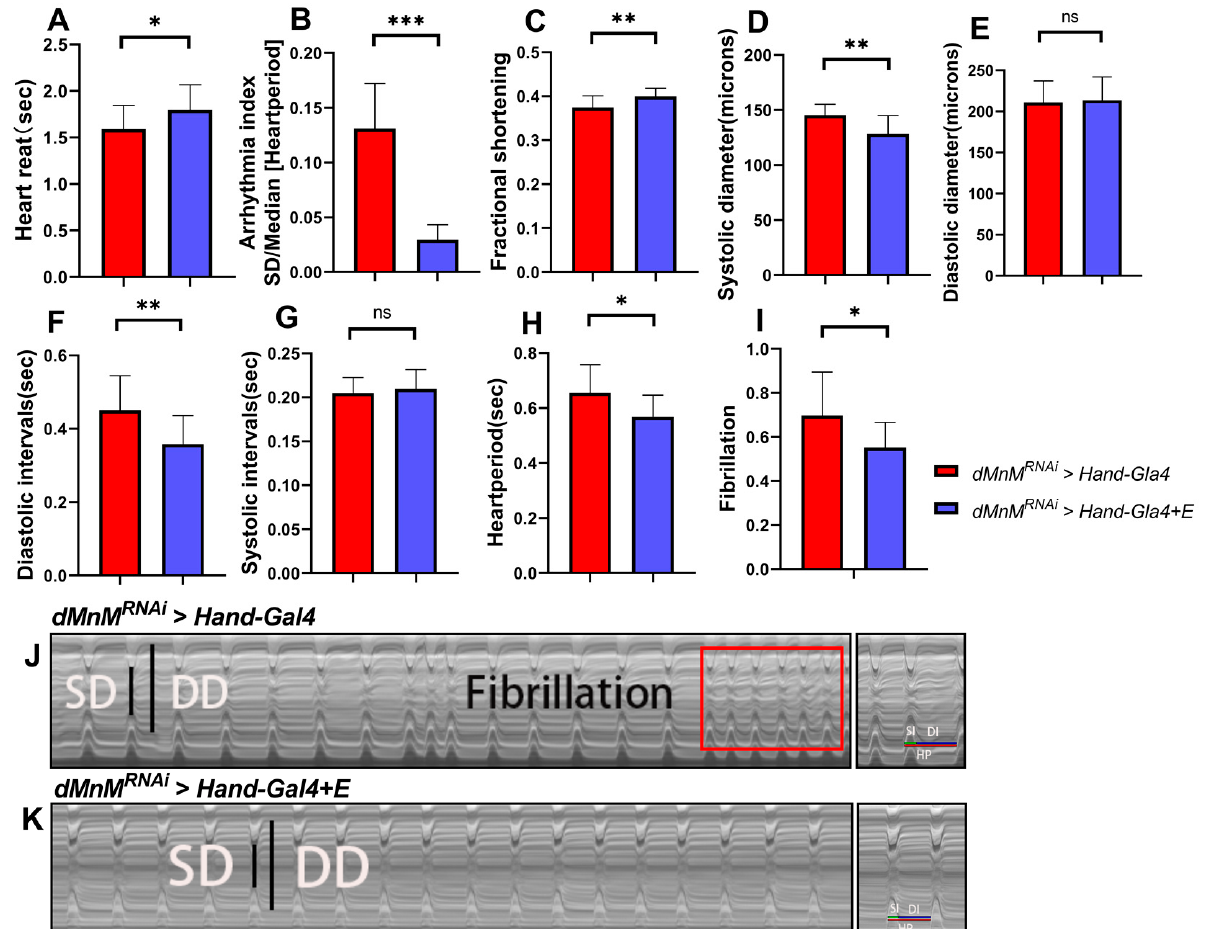
Figure 5. Effect of regular exercise on dMnM-specific knockdown of cardiac function in Drosophila cardiomyocytes. ( A – H ) HR, AI, FS, SD, DD, DI, SI, HP, and FL in the dMnM RNAi > Hand-Gal4 group and the dMnM RNAi > Hand-Gal4 + E group, n= 30. ( I ) Fibrillation levels in Drosophila. ( J , K ) Drosophila M-mode ECG pattern. Long and short black lines represent diastolic diameter and systolic diameter, respectively. The red square shows fibrillation. Rectangular area represents fibrillation. All M-mode ECGs were intercepted for 10 s. An independent-samples t -test and nonparametric test were used to assess the differences between the two groups, * p < 0.05, ** p < 0.01, *** p < 0.001, ns is not statistically significant.